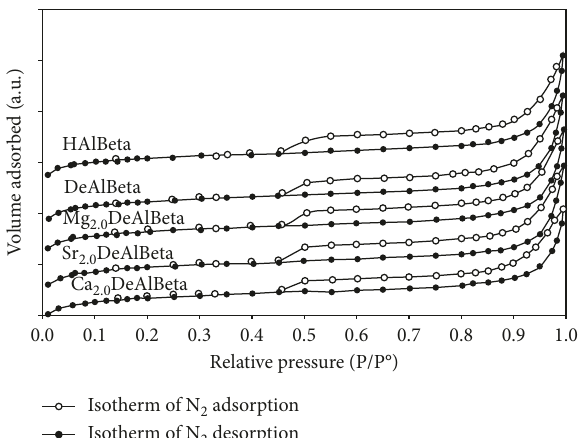
Figure 1: N 2 adsorption-desorption isotherms of HAlBeta, DeAlBeta, Mg 2.0 DeAlBeta, Sr 2.0 DeAlBeta, and Ca 2.0 DeAlBeta Table 1: Surface characteristic of samples determined by the N Sample